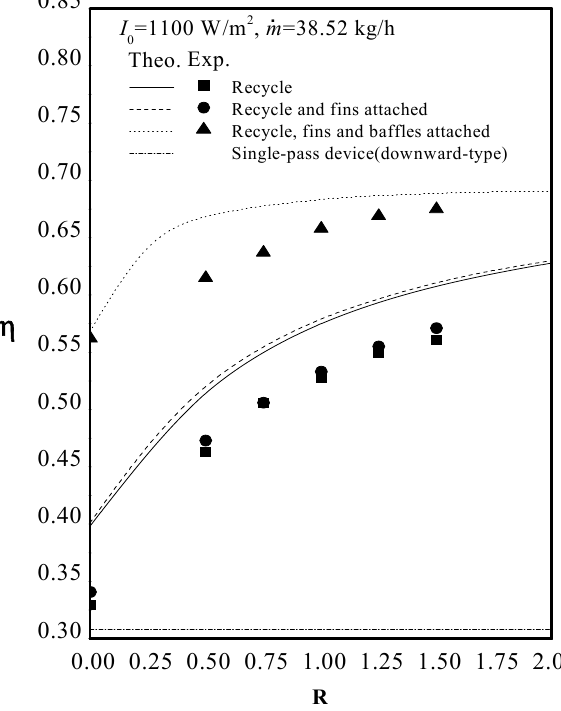
Figure 7. Effect of recycle ratio on collector efficiency in a double-pass flat-plate solar air = 1100 W/m 2 , m  = 38.52 heater with recycle; I 0